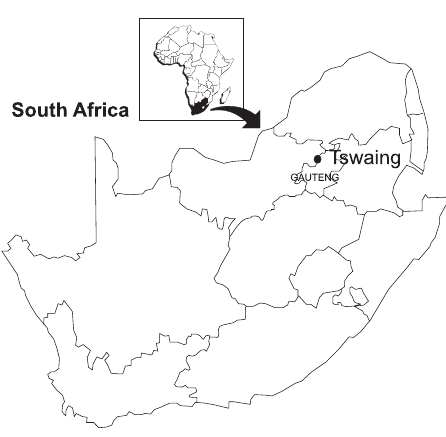
Fig.1. Tswaing Meteorite Crater's location in South